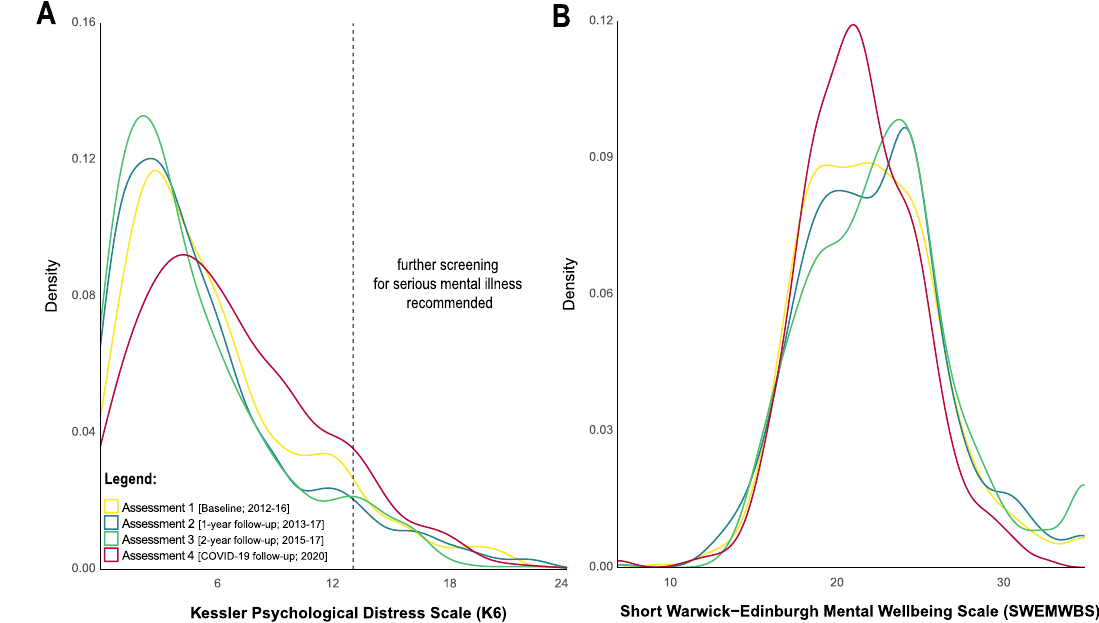
Figure 3. Density distributions for pre-pandemic data collection periods and data collected mid-pandemic for both primary outcome measures; the Kessler Psychological Distress Scale ( A ) and the Short Warwick- Edinburgh Mental Wellbeing Scale ( B ).